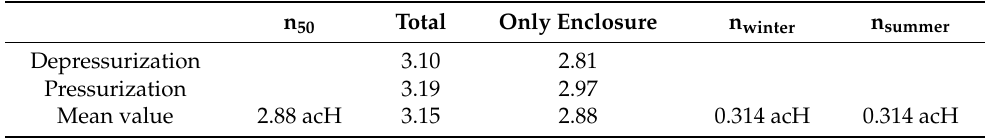
Figure 19. The blower door test. June 2015. Table 7. The calculation of air infiltration in the envelope n 50 .